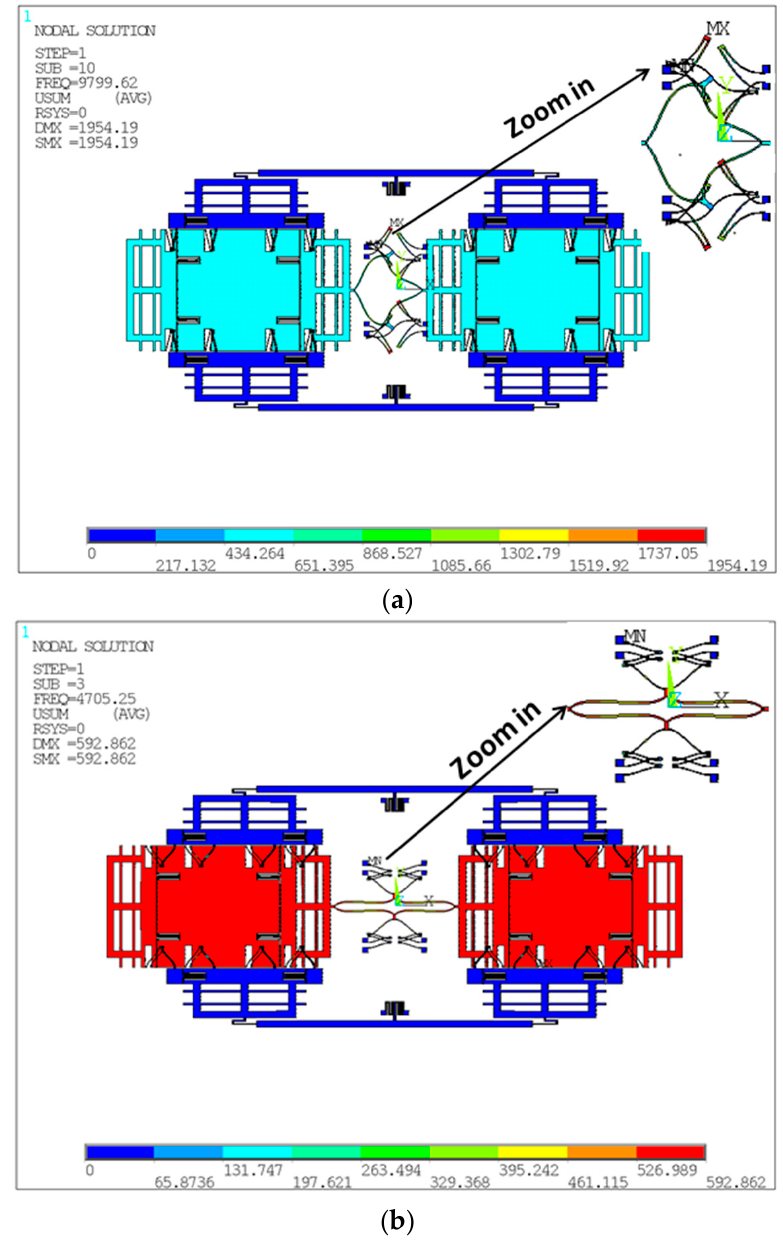
Figure 2. Modal analysis of the in-phase mode ( a ) and anti-phase mode ( b ) of Type A.